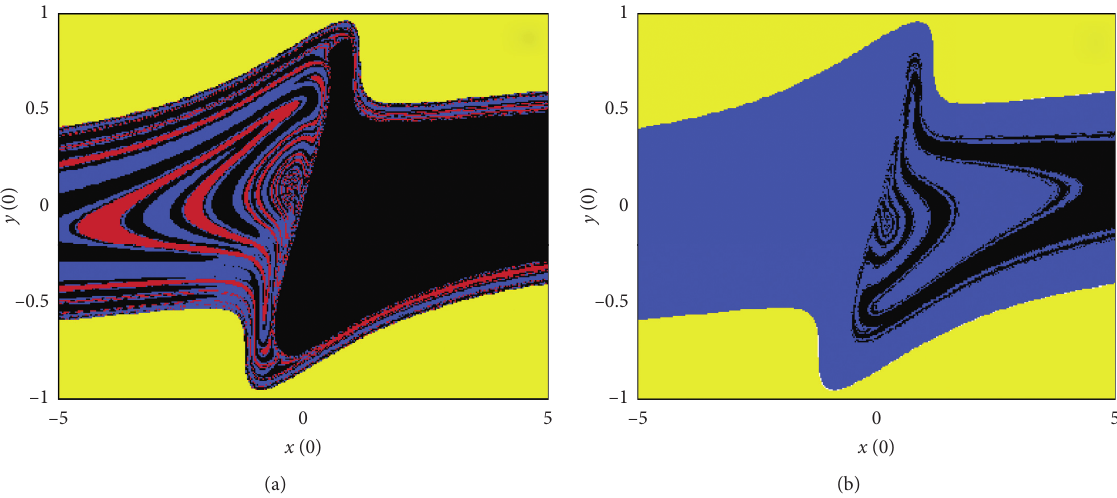
Figure 8: Basin of attractions in the plane ( x ( 0 ) , y ( 0 )) for δ � 0 . 15 (resp. δ � 0 . 3) showing magnetization toward a unique stable state when the coupling strength is increased according to Figure